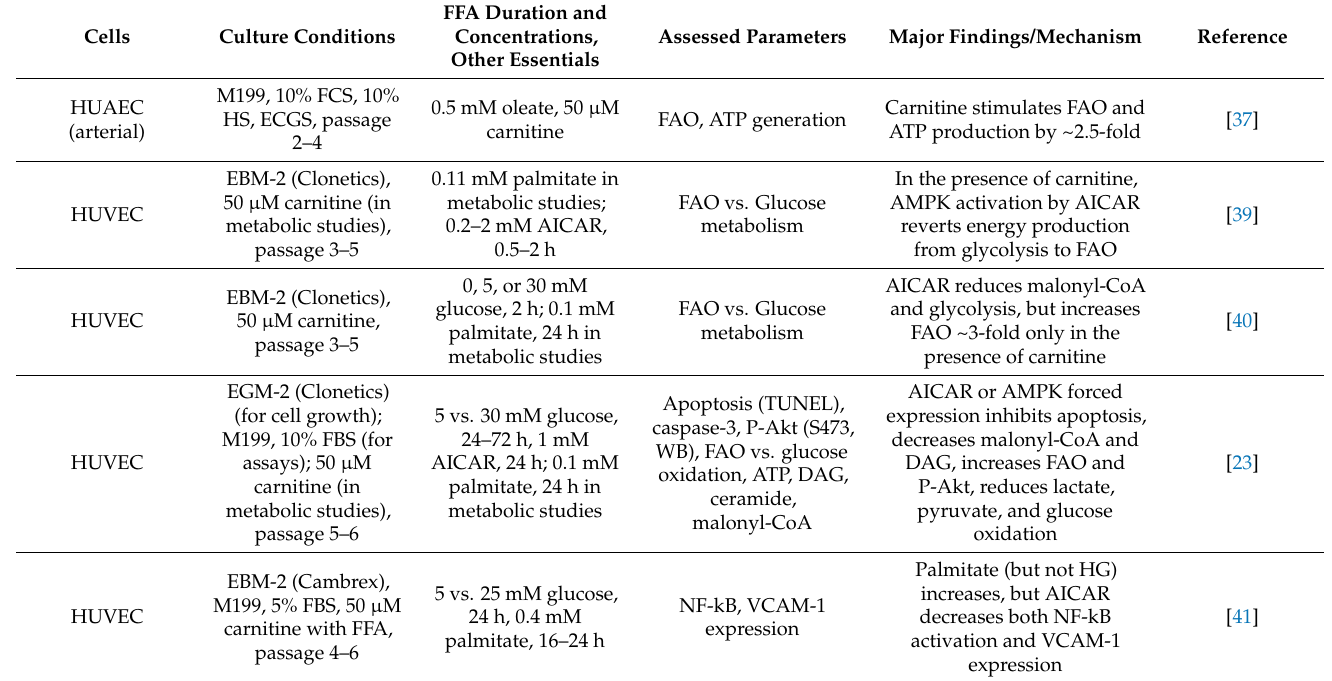
Table 1. Effects of carnitine on endothelial cells in